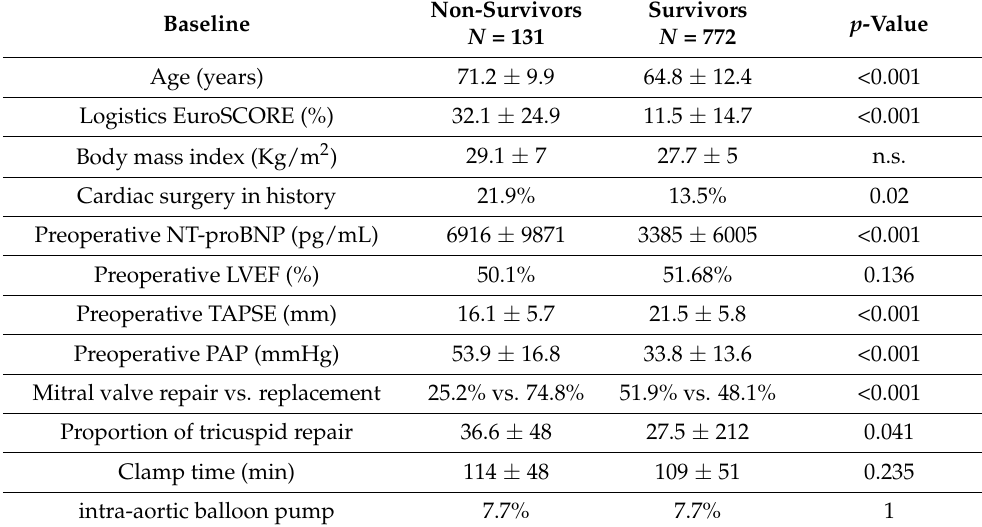
Table 2. Baseline and surgical